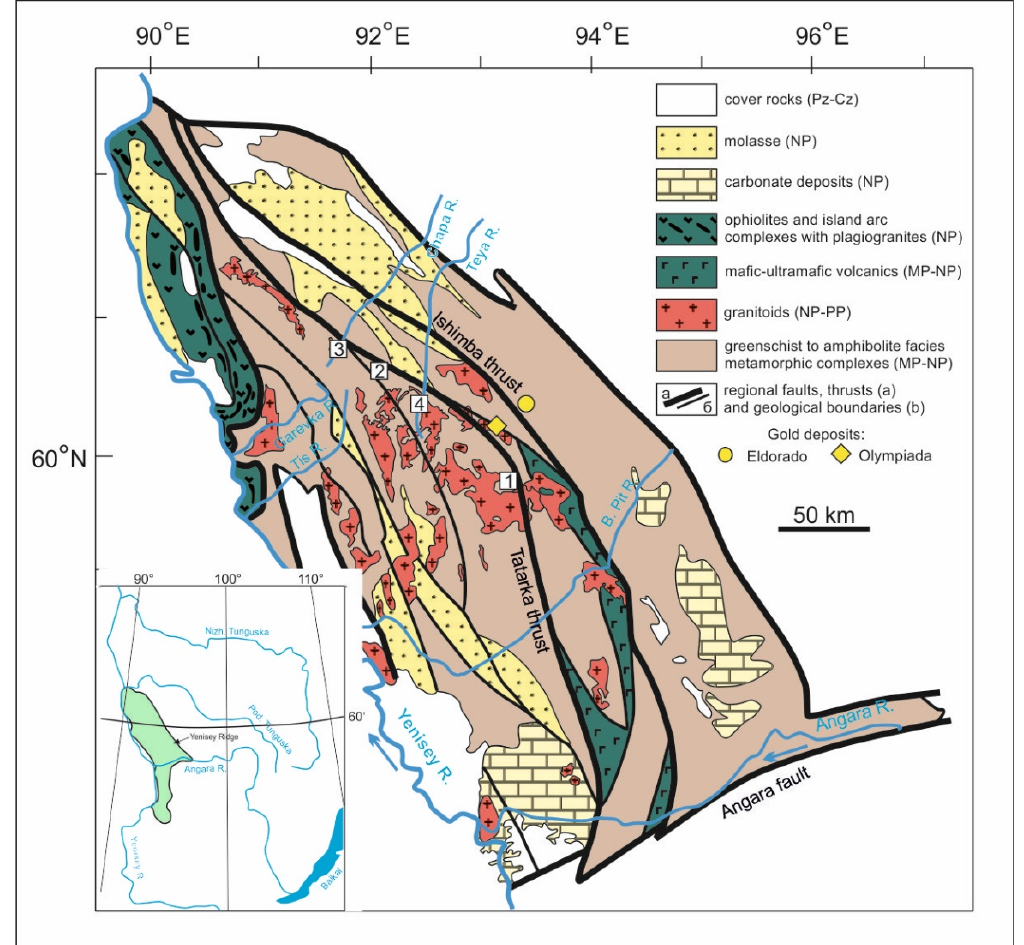
Figure 1. Geological sketch map of the northern part of the Yenisey Ridge showing location of the Olympiada and Eldorado gold deposits and areas mentioned in the text (numbers in squares): 1—Mayakon; 2—Polkan; 3—Chapa, 4—Teya. Compiled after [11,14,24].